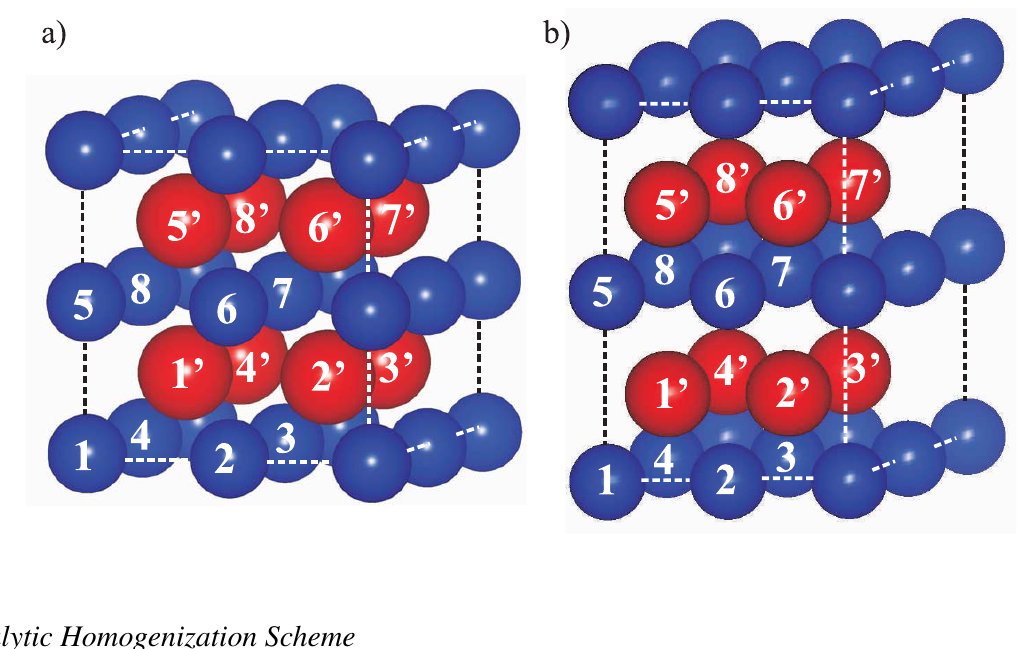
Figure 2. ( a ) The 2 × 2 × 2 16-atomic supercells used in the calculations of the cubic phase alloys; and ( b ) the hexagonal close-packed ones, with one half or the atoms (numbered 1–8) located in odd atomic layers and the second half (numbered 1’–8’) in even atomic layers (for sake of clarity depicted by larger red spheres) in the [001] β -Ti-37.5at.% Nb alloys were modeled by two different ordered compounds with the Nb atoms located in positions marked in the figure by either numbers { 124678 } (below referred to as β -Ti-Nb I ) or the set { 1 (cid:48) 24577 (cid:48) } (further referred to as β -Ti-Nb II